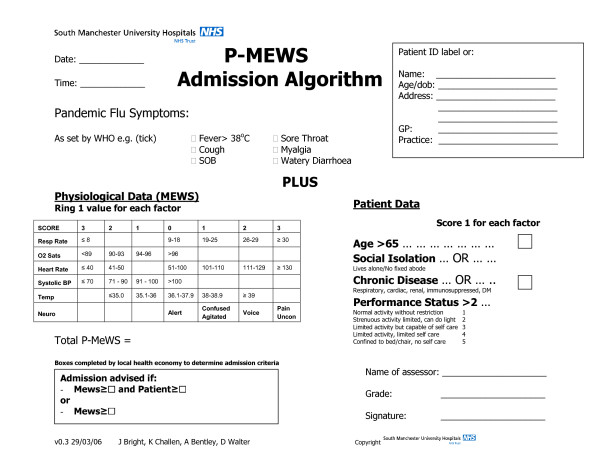
PMEWS algorithm.